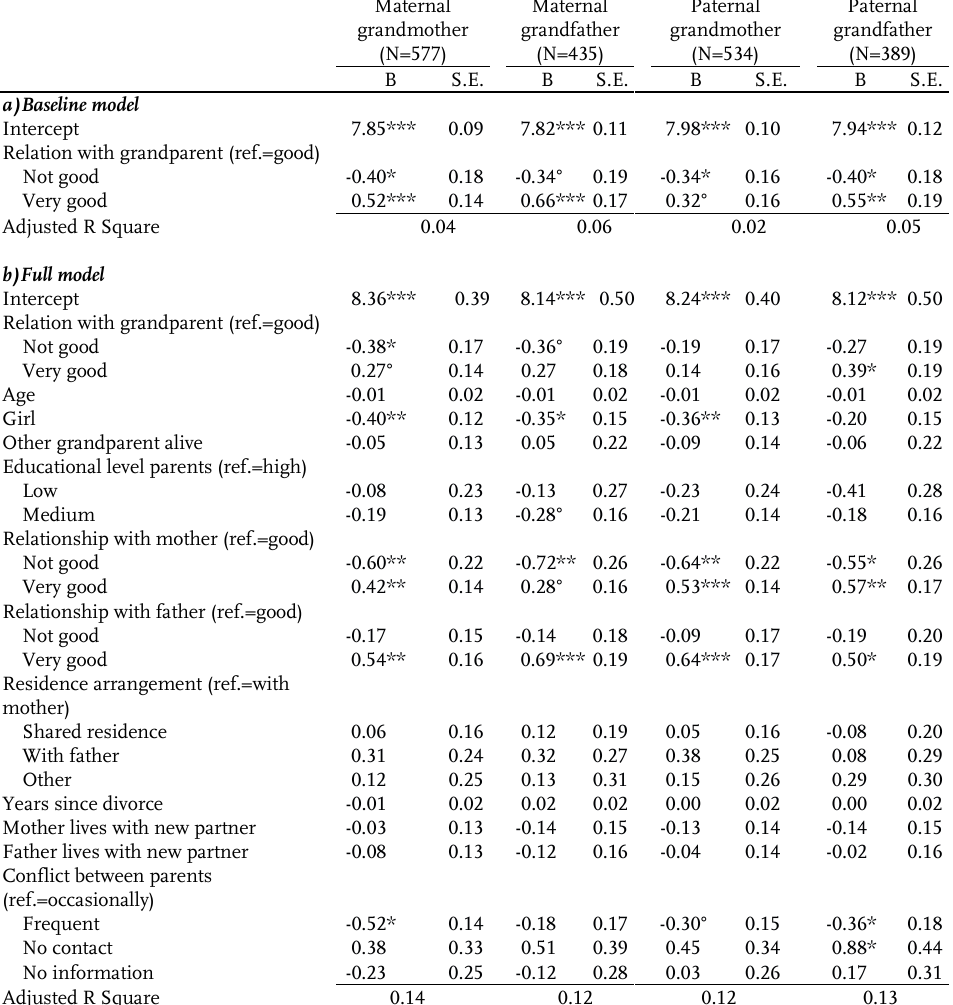
Table 2 : Linear regression analyses of grandchildren’s life